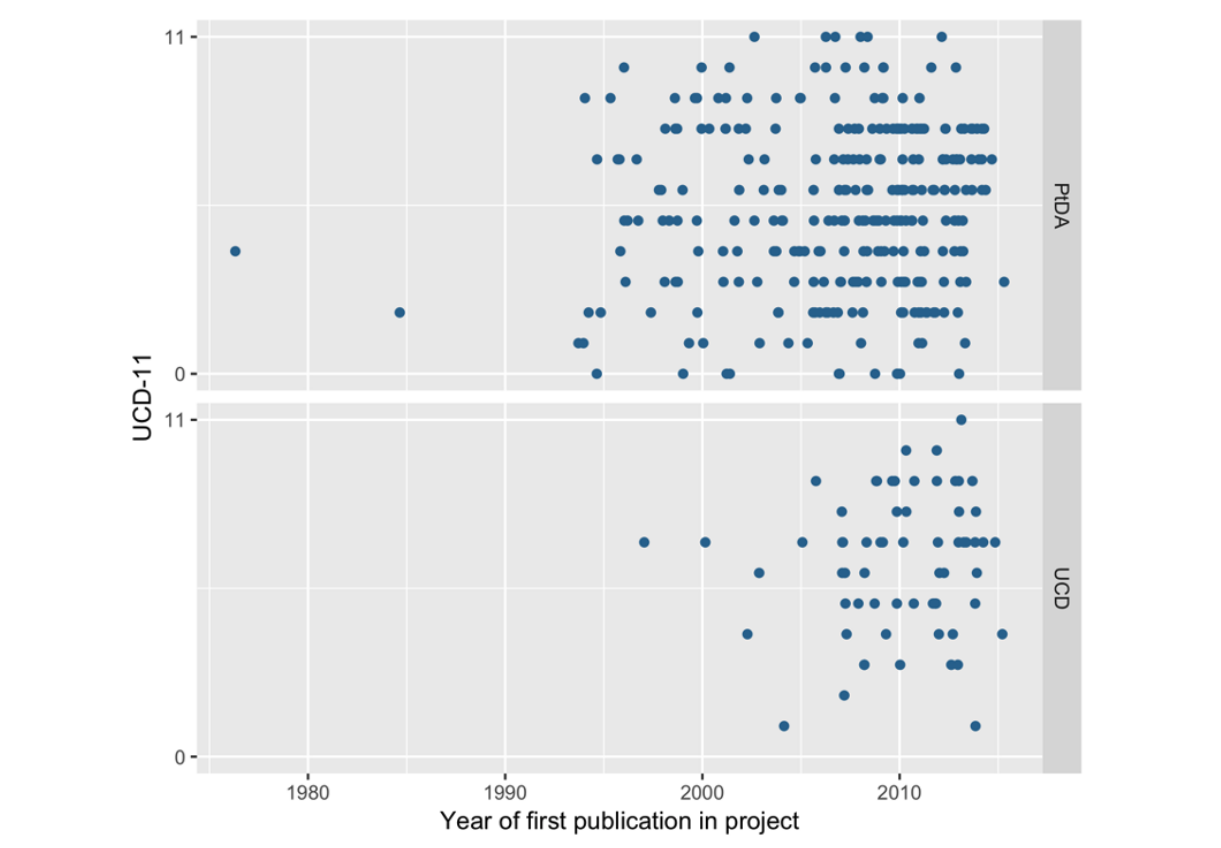
Figure 3. User-Centered Design 11-Item scale (UCD-11) scores by year of publication of the first paper describing a project. UCD refers to other personal health tools explicitly naming user- or human-centered design as the guiding process. PtDA: patient decision